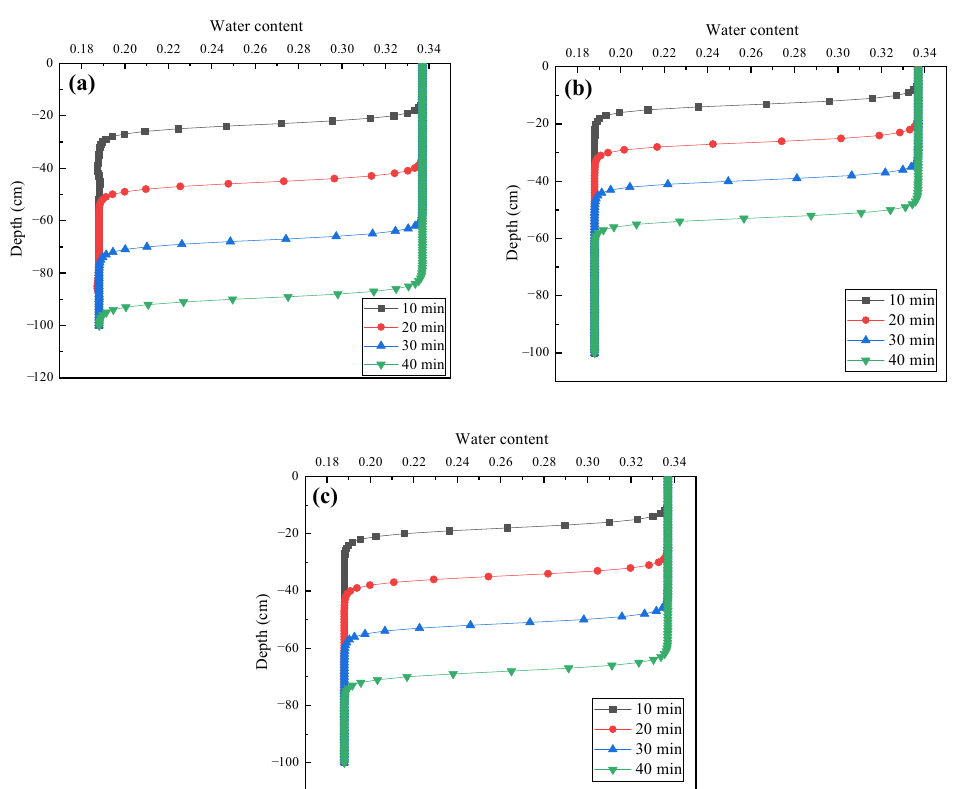
Figure 10. Water infiltration profiles at 10 min, 20 min, 30 min, and 40 min for different soil types,